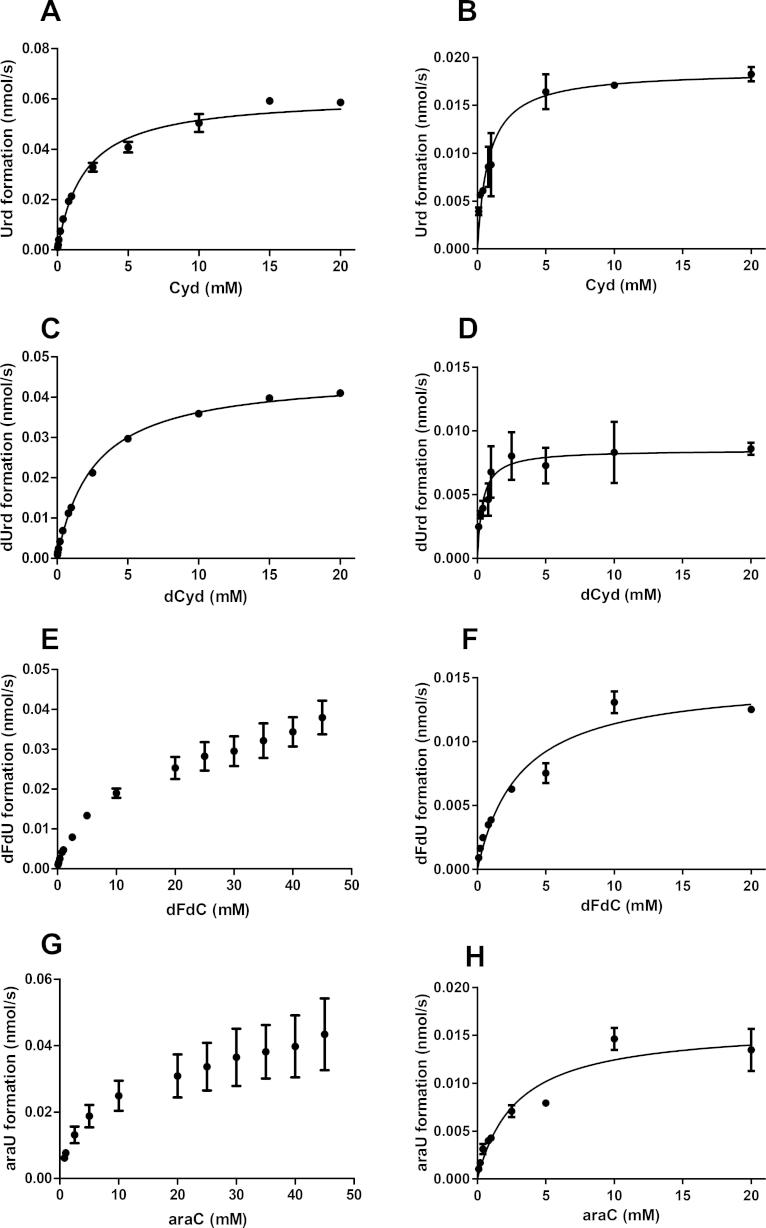
Kinetic analysis of CDAHyor- and CDAHuman-catalyzed deamination of natural nucleosides and nucleoside analogues Deamination of different concentrations of Cyd (A and B), dCyd (C and D), dFdC (E and F) and ara-Cyd (G and H) by CDAHyor (A, C, E and G) or CDAHuman (B, D, F and H). The data are the mean of at least two independent experiments (±S.E.M.).